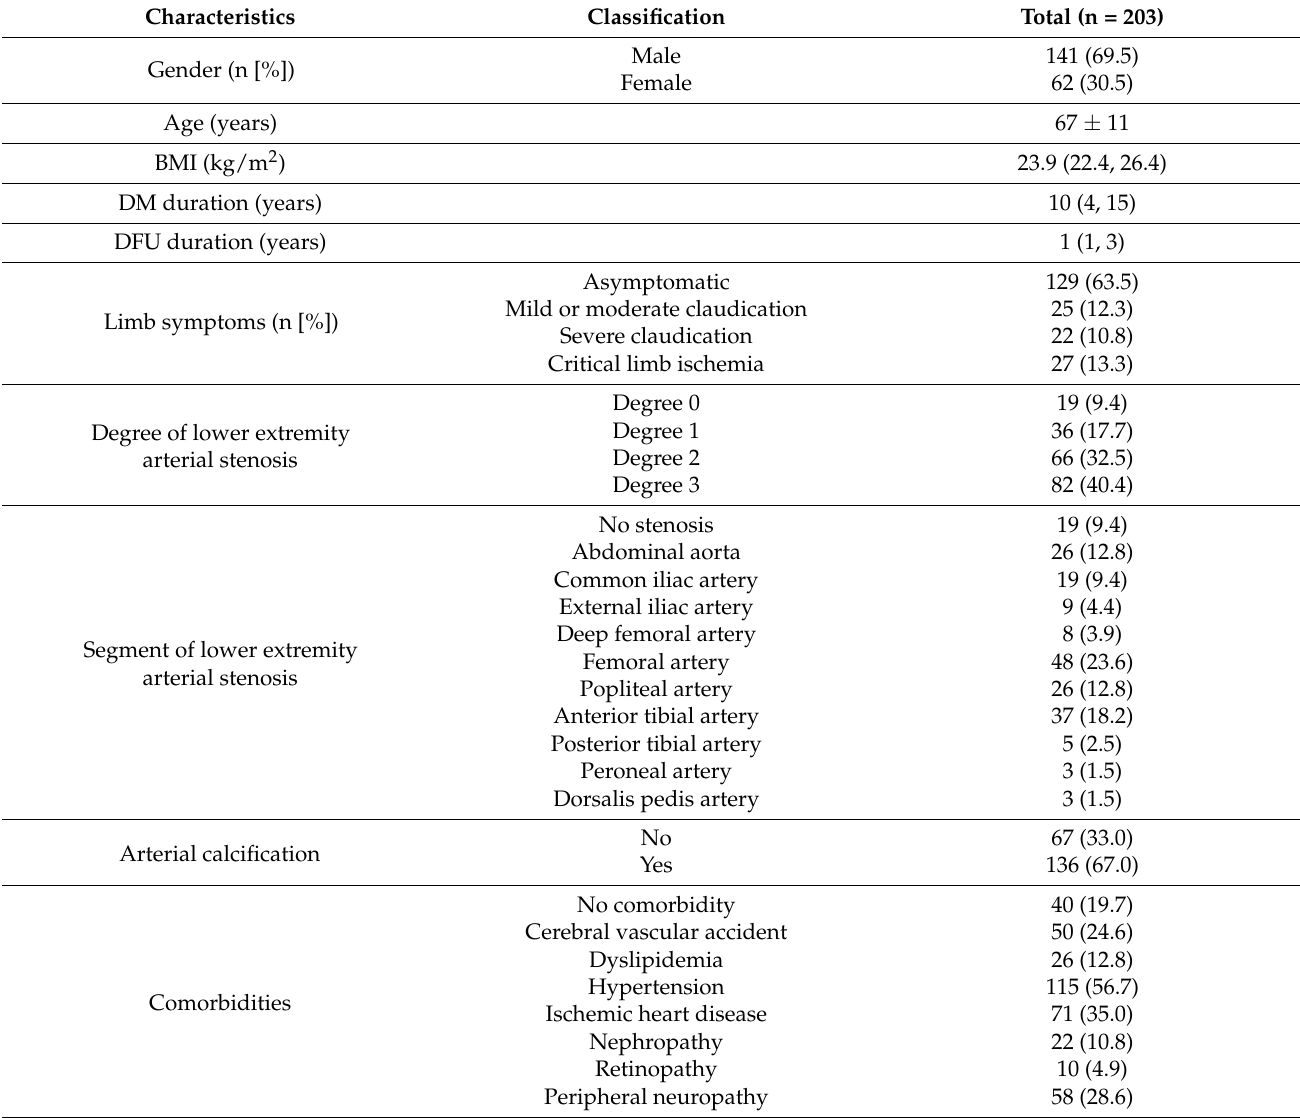
Table 1. Demographic and clinical characteristics of study